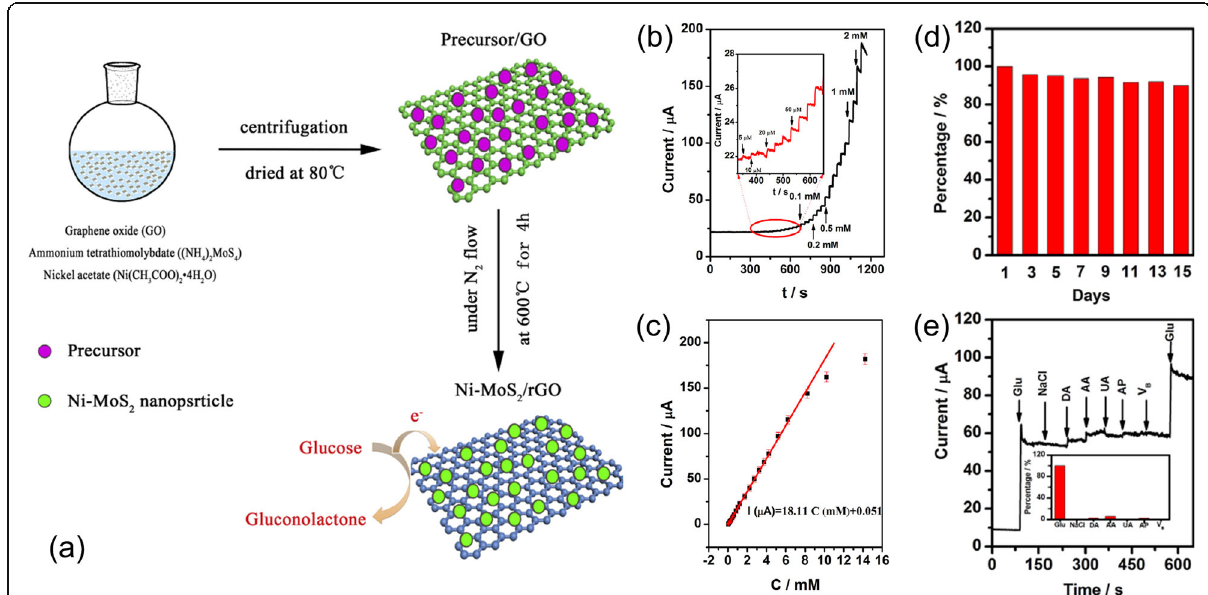
Fig. 1 a Schematic of the synthesis of Ni-MoS 2 /rGO composites. b Amperometric response of a Ni-MoS 2 /rGO sensor to the successive addition of glucose. c The extracted response current to different glucose concentrations. d Stability test of the sensor by amperometric measurement for 15 days. e Comparison of the amperometric responses of 2.5 mM glucose and 0.1 mM interference chemicals. Reprinted from [25], Copyright 2017, with permission from